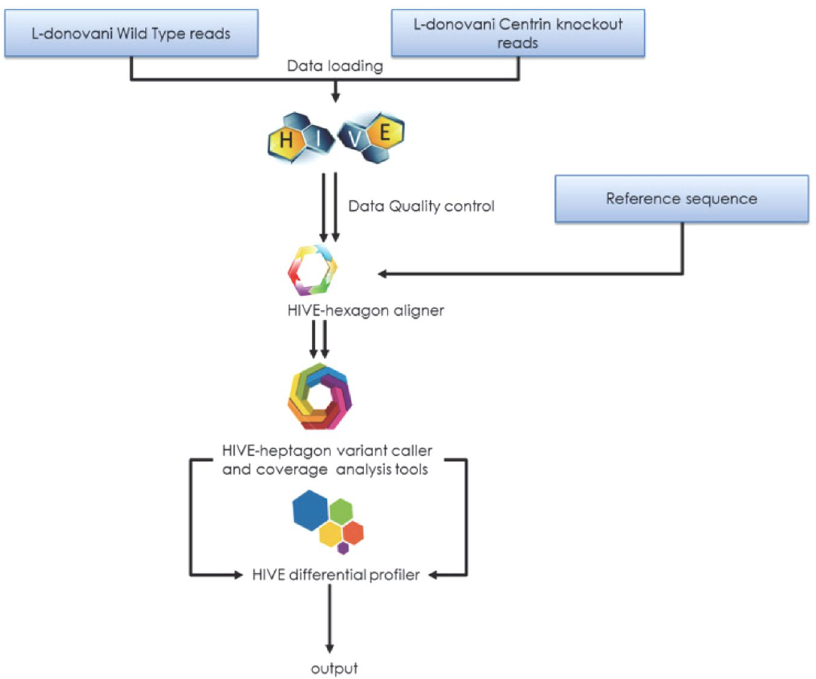
Figure 1. Bioinformatics workflow cataloging the steps taken to analyze the LdWT and LdCen − / − reads. These steps include (i) the sequencing of the two genomes, (ii) upload of the raw data into the HIVE system, (iii) validation through NGS quality controls, (iv) aligning the two sets of raw data independently against the reference genome ( L . infantum or L . donovani ) using the HIVE Hexagon aligner, (v) variant calls on the alignments using the HIVE Heptagon variant caller, (vi) mapping of the generated profiles (SNV calls and gaps) to determine differences between profiles (gaps of ≥ 300 bp), and (vii) manual validation of the